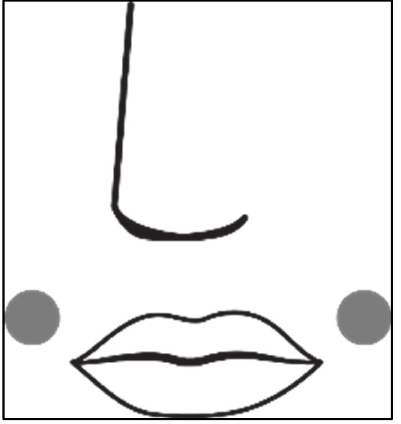
Figure 3. Illustration of placement of iButtons on the face.